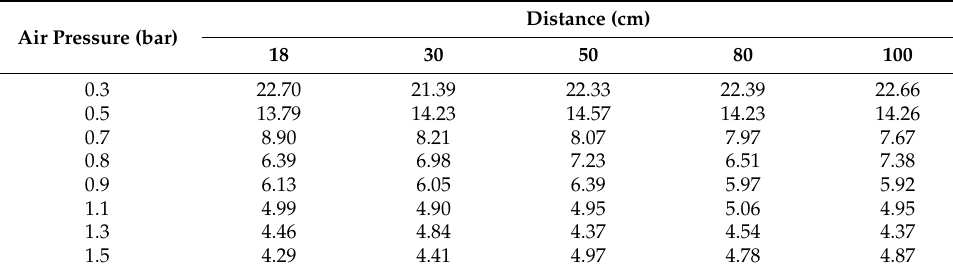
Table 4. Simulation results of atomization